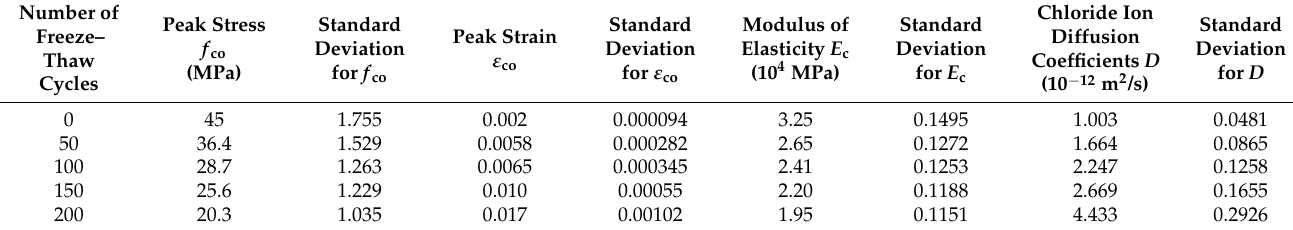
Table 2. Experimental test results of the concrete deterioration